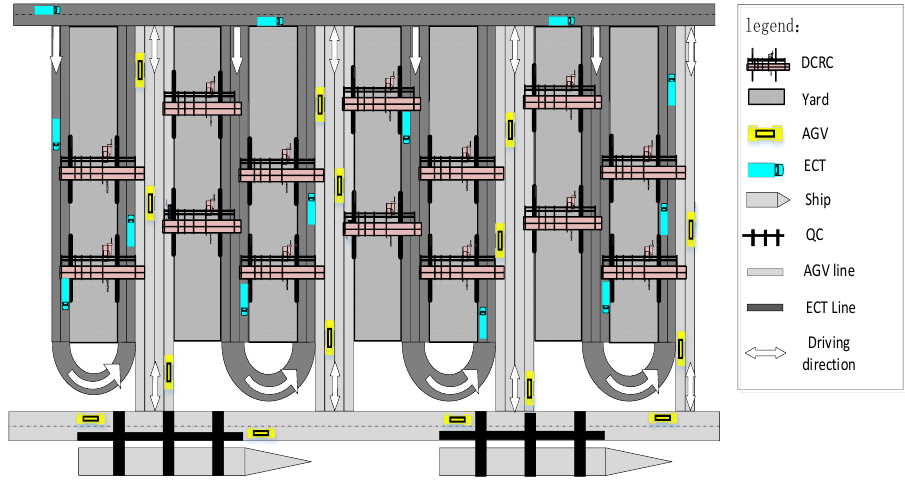
Figure 1. Layout of the U-shaped ACT.